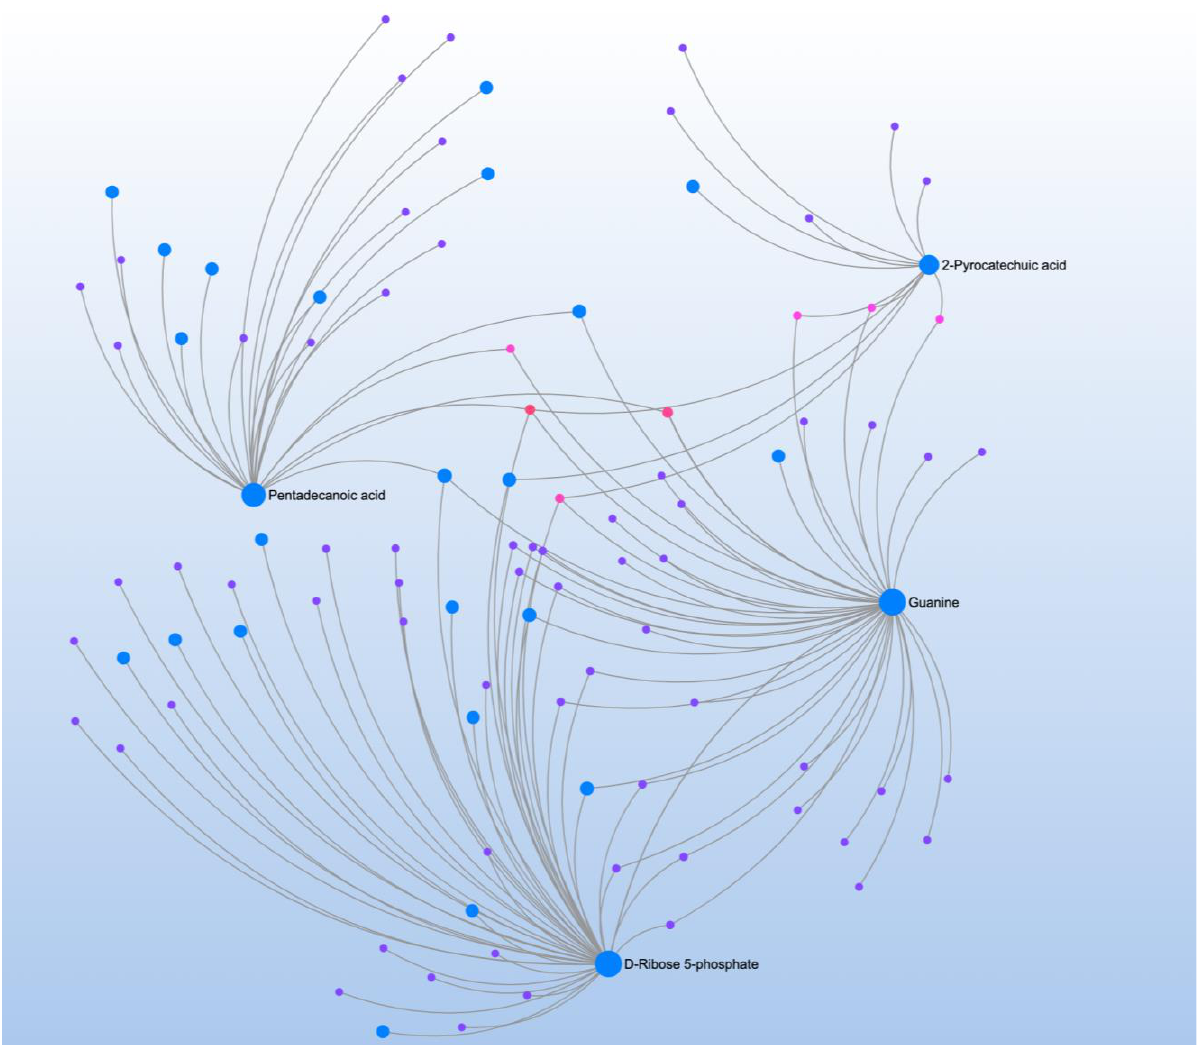
Figure 3. Metabolite-metabolite interaction network for significant metabolites that correlate to sleep problems. Size of the node indicates importance in the network. The interaction analysis confirmed the role of D-ribose 5-phosphate, an essential product of the pentose phosphate pathway that can be used to synthesize guanosine triphosphate and adenosine triphosphate. Table 6. Metabolites and their pathways which correlate with